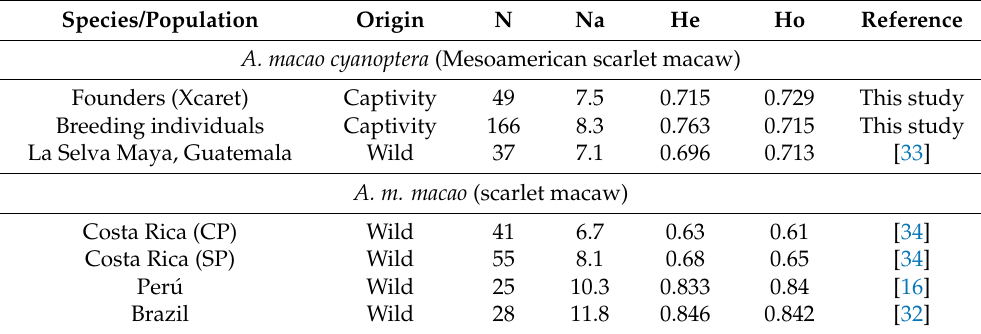
Table 2. Population origin, sample size (N), number of alleles (A), and expected (He) and observed (Ho) heterozygosities of microsatellite loci in the two subspecies of scarlet macaws studied to date. Species/Population Origin N Na He Ho Reference A. macao cyanoptera (Mesoamerican scarlet macaw) Founders (Xcaret) Captivity 49 7.5 0.715 0.729 This study Breeding individuals Captivity 166 8.3 0.763 0.715 This study La Selva Maya, Guatemala Wild 37 7.1 0.696 0.713 [33] A. m. macao (scarlet macaw) Costa Rica (CP) Wild 41 6.7 0.63 0.61 [34] Costa Rica (SP) Wild 55 8.1 0.68 0.65 [34] Per ú Wild 25 10.3 0.833 0.84 [16] Brazil Wild 28 11.8 0.846 0.842